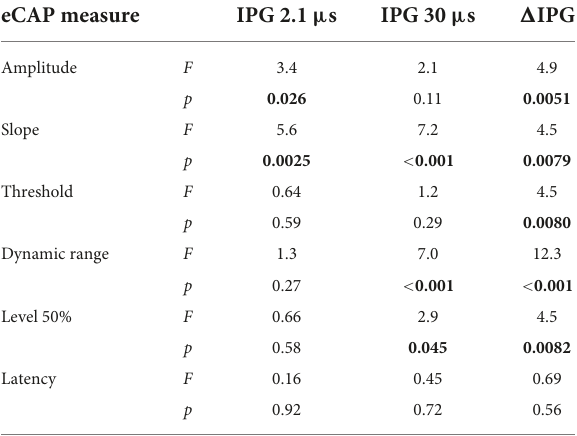
TABLE 4 F - and P -values of the ANOVA on eCAP characteristics of both an IPG of 2.1 and 30 µ s, and (cid:49) IPG. eCAP measure IPG 2.1 µ